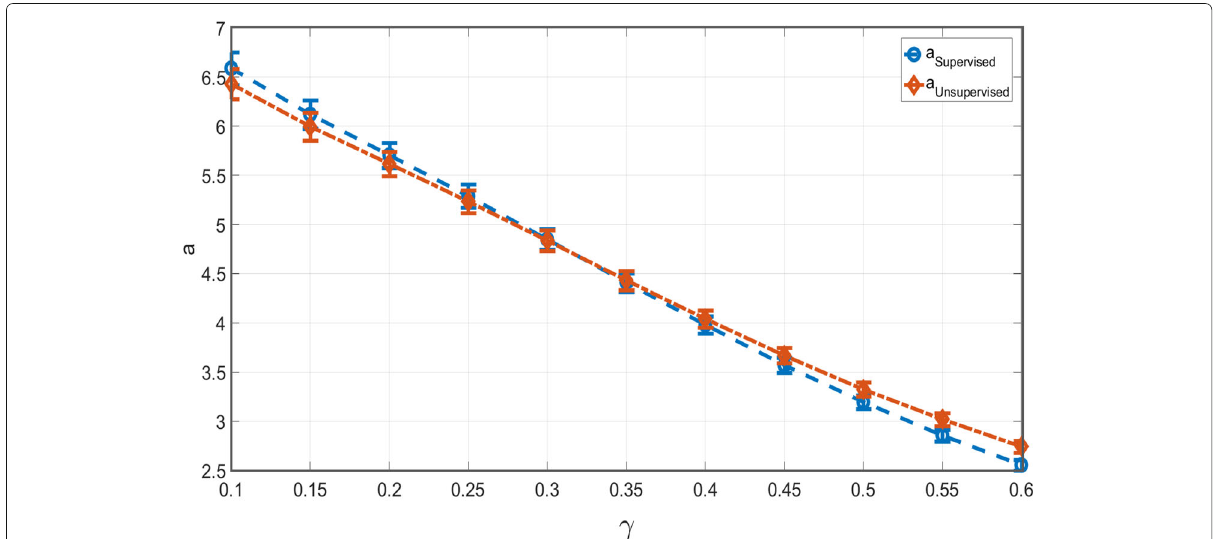
Fig. 5 Estimation of the a parameter. Comparison of the mean and standard deviation evolution for parameter a as a function of the dispersion γ of a S α S noise with α = 1.4 for the supervised and unsupervised optimization